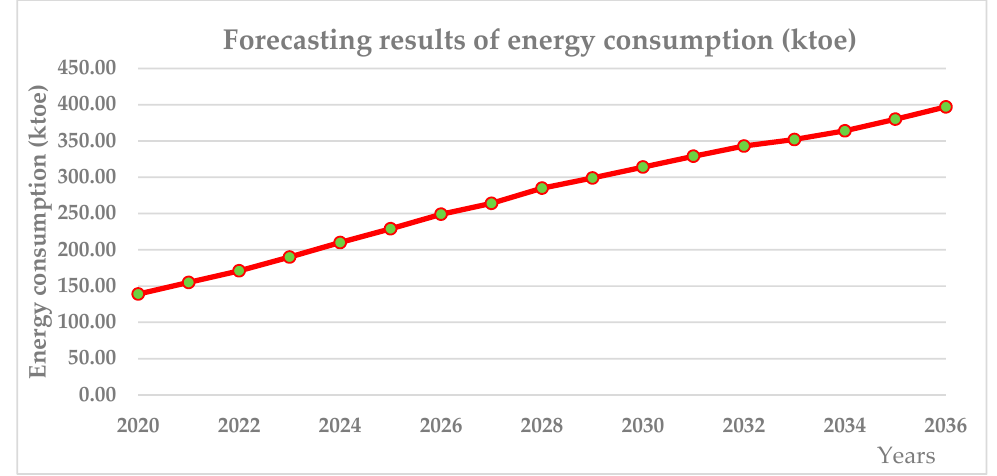
Figure 3. The forecasting results of energy consumption from 2020 to 2036 in Thailand .